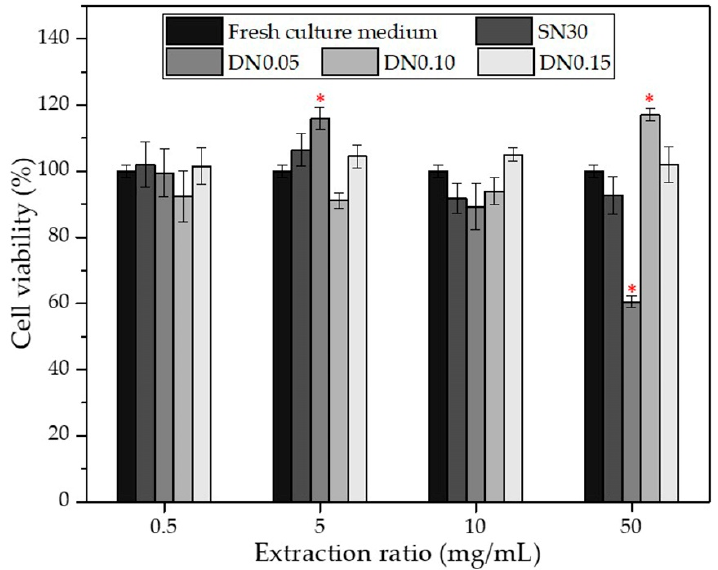
Figure 12. Viability of human chondrocytes after incubating with hydrogels extracted culture media at different extraction ratio ( n = 3 , * p < 0.05 compared with fresh culture medium).